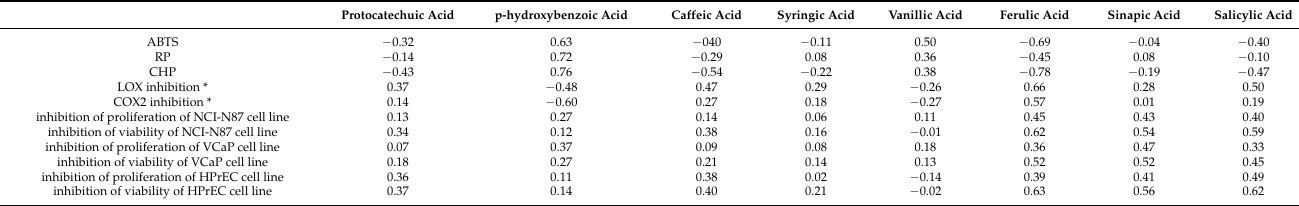
Table 3. Pearson’s correlation coefficients for phenolic acid content and in vitro bioactivities.